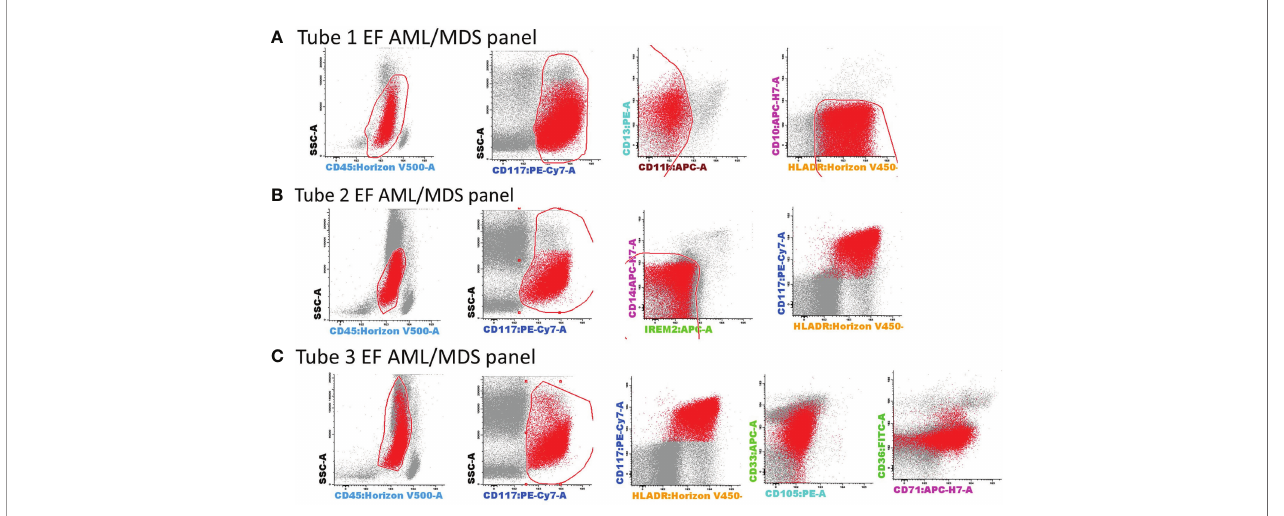
FIGURE 3 | Gating strategy for the selection of AML blasts using tubes 1 – 3 of the EF AML/MDS panel. AML blasts were selected based on the expression of backbone markers, CD117, human leukocyte antigen-DR (HLA-DR), and CD45 +low . Several exclusion gates were used to avoid the inclusion of undesirable events that may fall into the blast gate, such as CD11b + hypogranular neutrophils and basophils (tube 1), CD14 +low granulocytes and CD14 + CD300e (IREM-2) + monocytes (tube 2), and CD10 + hematogones (tube 1). Bivariate dot plots illustrating a representative example of AML blast identi fi cation using the antibody combinations from tubes 1 – 3 of the EF AML/MDS panel. AML blasts (red dots), other singlet events (gray dots). (A) tube 1 EF AML/MDS panel; (B) tube 2 EF AML/MDS panel, (C) tube 3 EF AML/MDS panel.